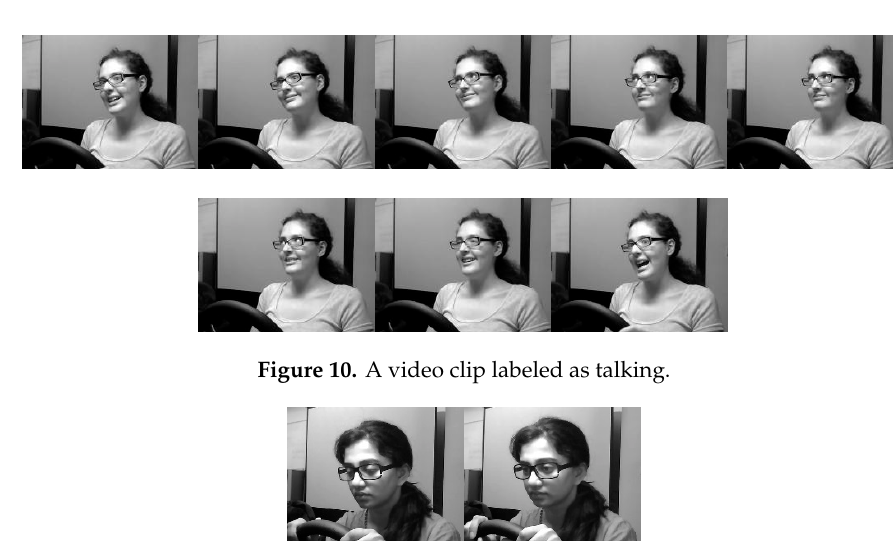
Figure 11. Two images labeled as drowsiness (left) and normal (right).